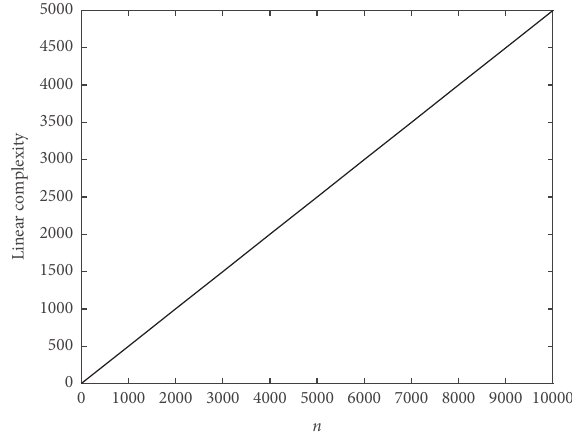
Figure 12: Linear complexity of the